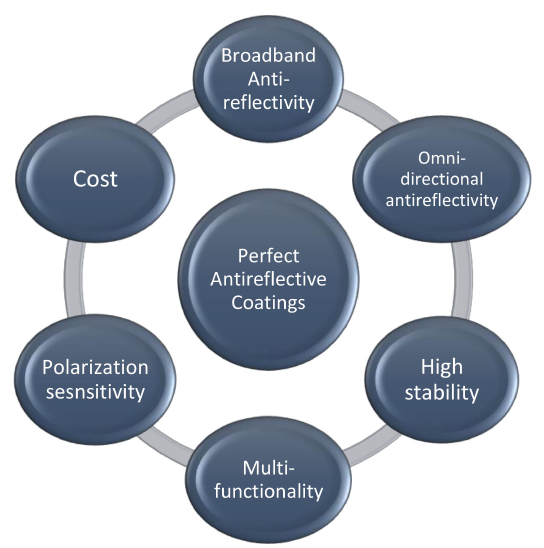
Figure 3. The various criterion for perfect antireflection coatings (ARCs).